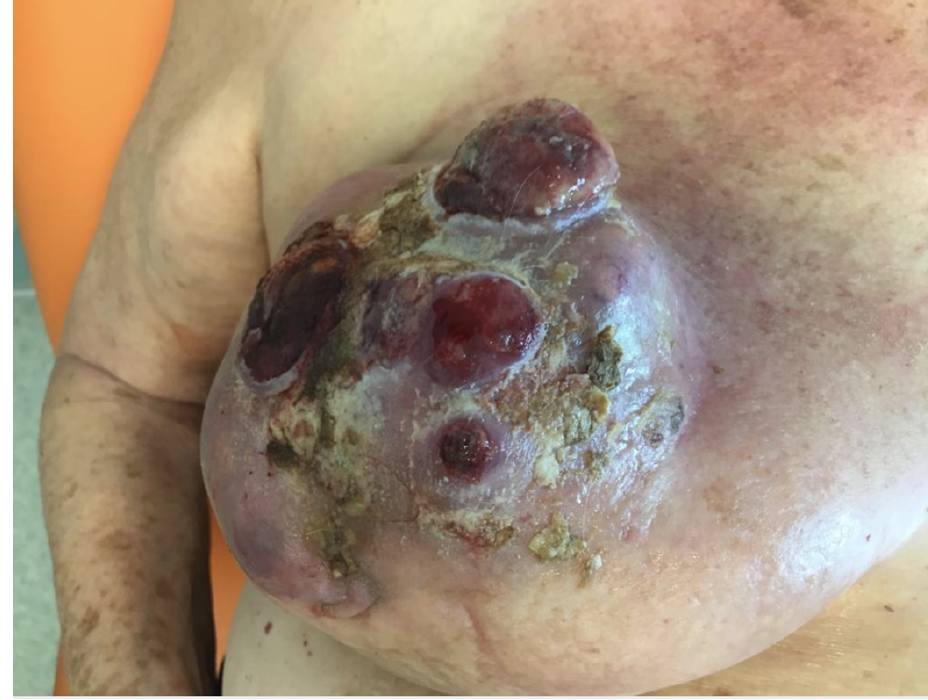
Figure 1. Necrotic area before the application.